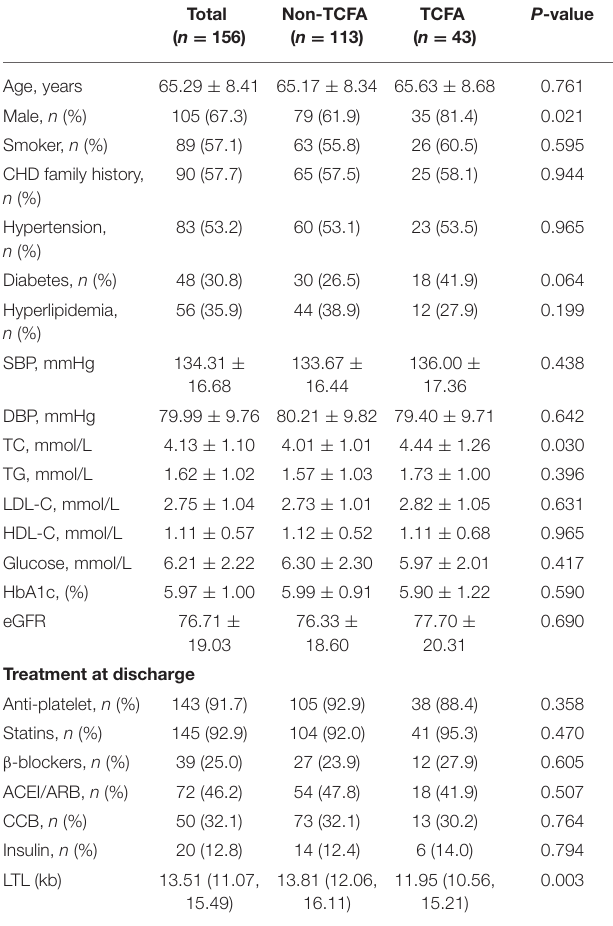
TABLE 1 | Baseline clinical characteristics